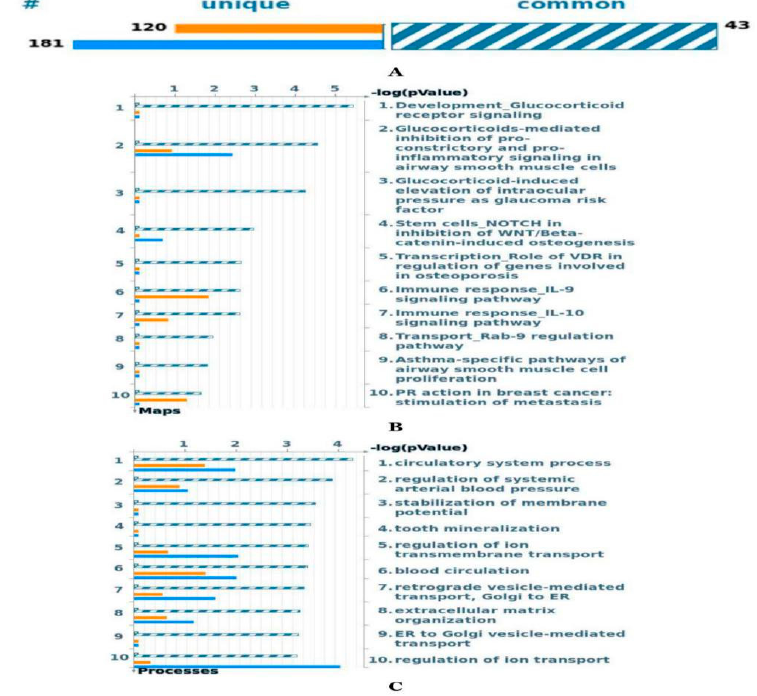
Figure 6. ( A ) The gene content is aligned between the moderate and severe asthma gene sets. The intersection set of experiments is defined as “common” and marked as a blue/white striped bar. The unique genes for moderate asthma are marked as orange, and for severe asthma as blue colored bars. ( B ) Canonical pathway maps represent a set of signaling and metabolic maps covering human in a comprehensive way. All maps are created by Clarivate Analytics scientists by a high-quality manual curation process based on published peer-reviewed literatures. ( C ) These are gene ontology (GO) cellular processes. As most GO processes have no gene / protein content, the “empty terms” are excluded from p -value